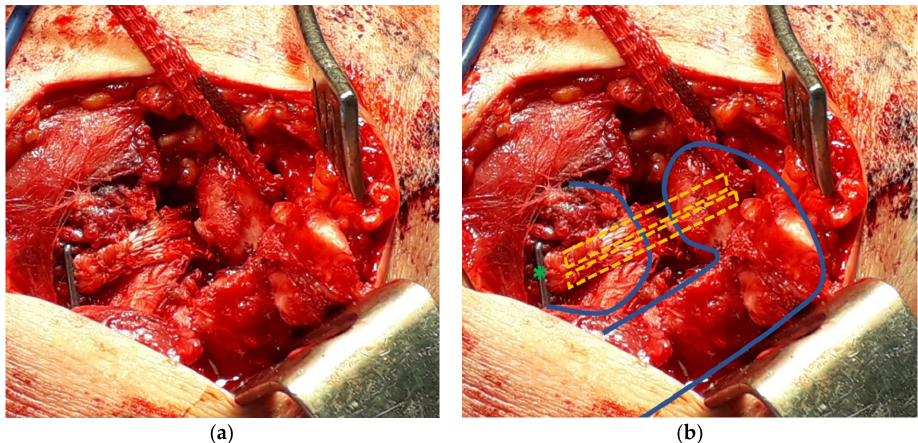
Figure 4. The final surgical result. ( a ) The final surgical result., ( b )the final construction (blue lines define acromion and clavicle, yellow dotted lines the synthetic ligament under the acromio-clavicular joint and the green asterisk (*) indicates the Infinity Lock titanium button.